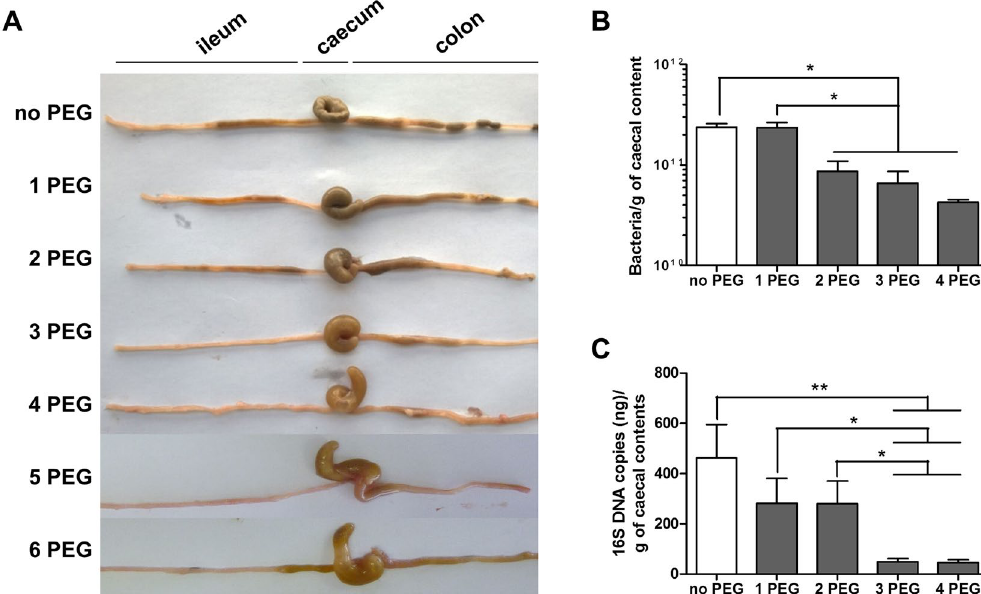
Figure 1. Effect of bowel cleansing with PEG on the microbiota. Mice were subjected to bowel cleansing with PEG solution by oral gavage. No PEG: no bowel cleansing; 1 PEG: mice receiving one bowel cleansing; 2 PEG: mice receiving two bowel cleansings; 3 PEG: mice receiving three bowel cleansings; 4 PEG: mice receiving four bowel cleansings; 5 PEG: mice receiving five bowel cleansings; 6 PEG: mice receiving six bowel cleansings. ( A ) Representative picture of the intestine of mice after bowel cleansing. ( B ) Quantification of luminal microbiota and ( C ) mucosal microbiota by Real-time qPCR analysis of the 16S rRNA gene. * p < 0.05, ** p <